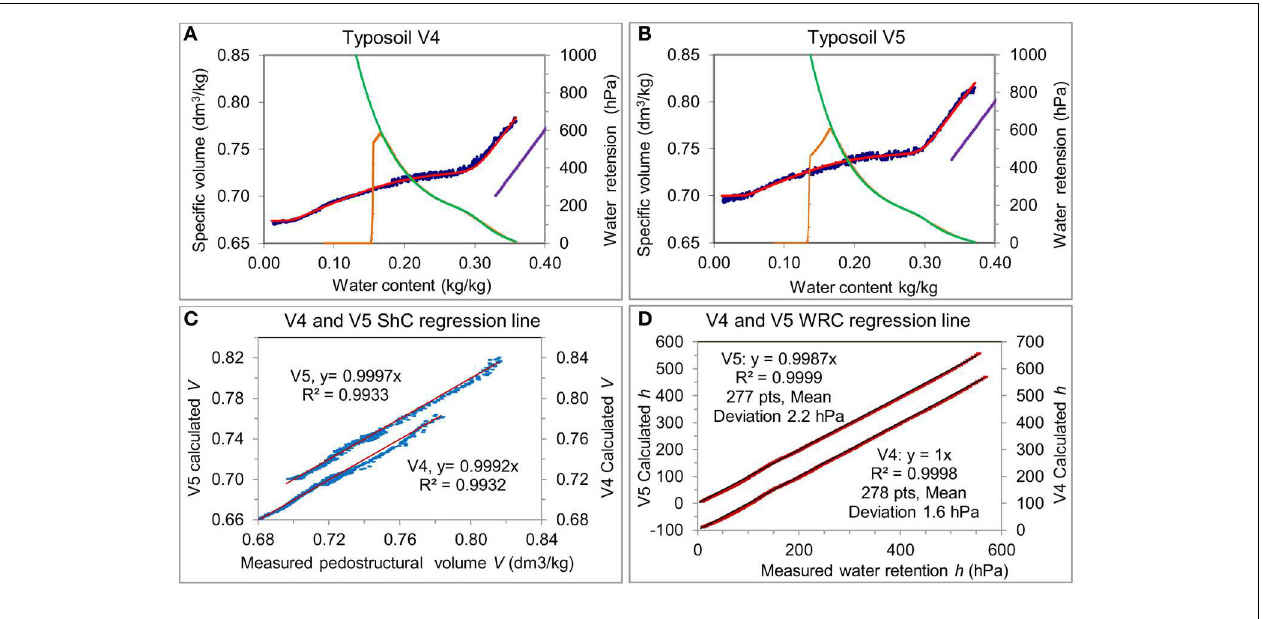
FIGURE 9 | Adjustment of the measured characteristic curves by their theoretical parametric equations for the Versailles soil type, V4 and V5. (A,B) represent for each sample the shrinkage curve (ShC), measured (blue points) and calculated (red line) with its